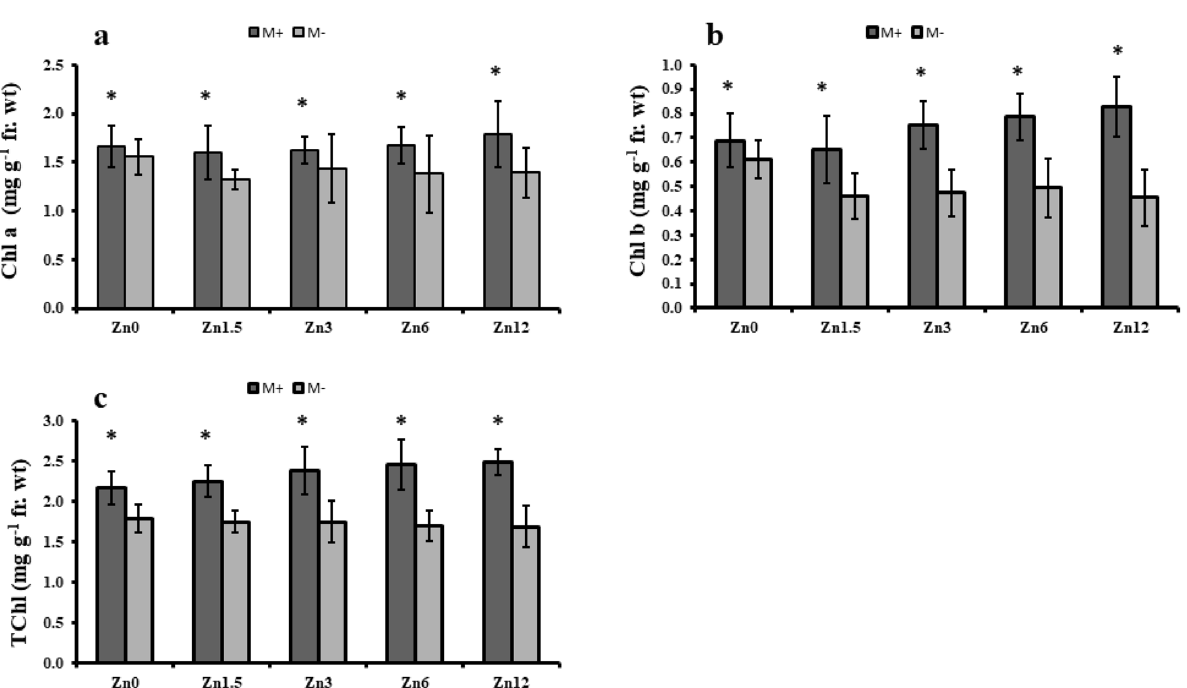
Figure 3. Effect of arbuscular mycorrhizal inoculation on chlorophyll contents of maize under zinc deficient soil conditions. ( a ) chlorophyll a content (mg g -1 fr. wt) ( b ) chlorophyll b contents (mg g -1 fr. wt) ( c ) total chlorophyll contents (mg g -1 fr. wt). Zn 0 (control), Zn 1.5 (1.5 mg kg -1 ), Zn 3 (3 mg kg -1 ), Zn 6 (6 mg kg -1 ), Zn 12 (12 mg kg -1 ), inoculated with AMF (M + grey), un-inoculated (M- white). Error bars represent standard error and asterisk (*) shows a significant difference ( p ≤ 0.05) among treatments (Zn × AMF